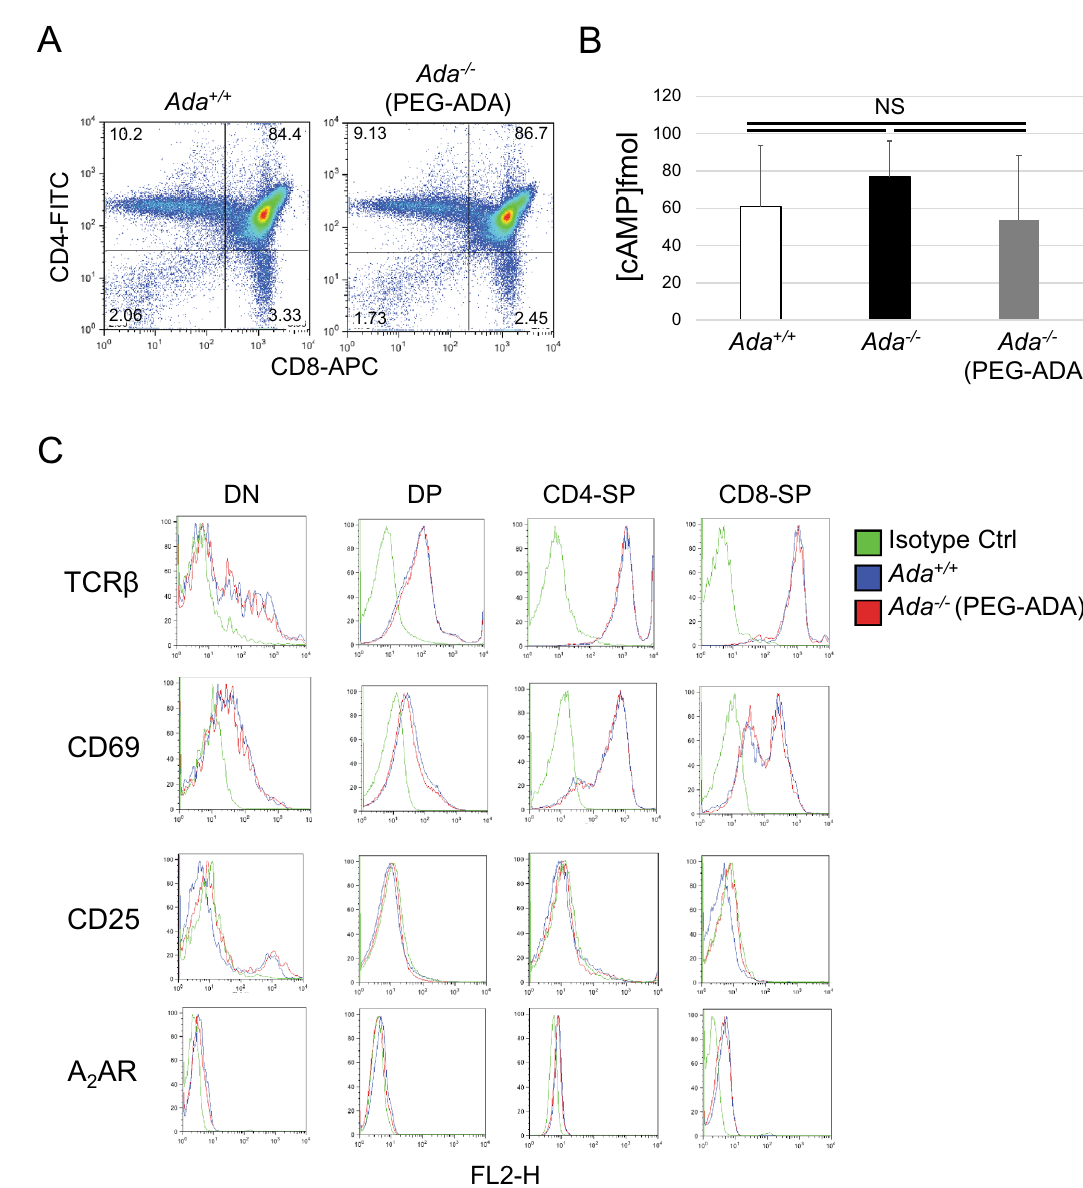
Figure 6. Ado accumulation does not interfere with thymocytes metabolism. ( A ) FACS plots of unfractionated thymocytes from control ( Ada + / + ) and 3-week-PEG-ADA-treated Ada −/− mice and gated for DN (CD4 − , CD8 − ), DP (CD4 + , CD8 + ), CD4-SP (CD4 + , CD8 − ) and CD8-SP (CD4 − , CD8 + ) populations. ( B ) Bar graph representing cAMP levels of thymocytes shown in (A) and of thymocytes from untreated Ada −/− mice at P14 (n = 3, 3, 3). ( C ) Each FACS-sorted cell populations shown in (A) were assessed for T cell surface receptors using PE-conjugated antibodies. FACS plots are representative of two replicate experiments (n = 3, 4). NS = statistically not